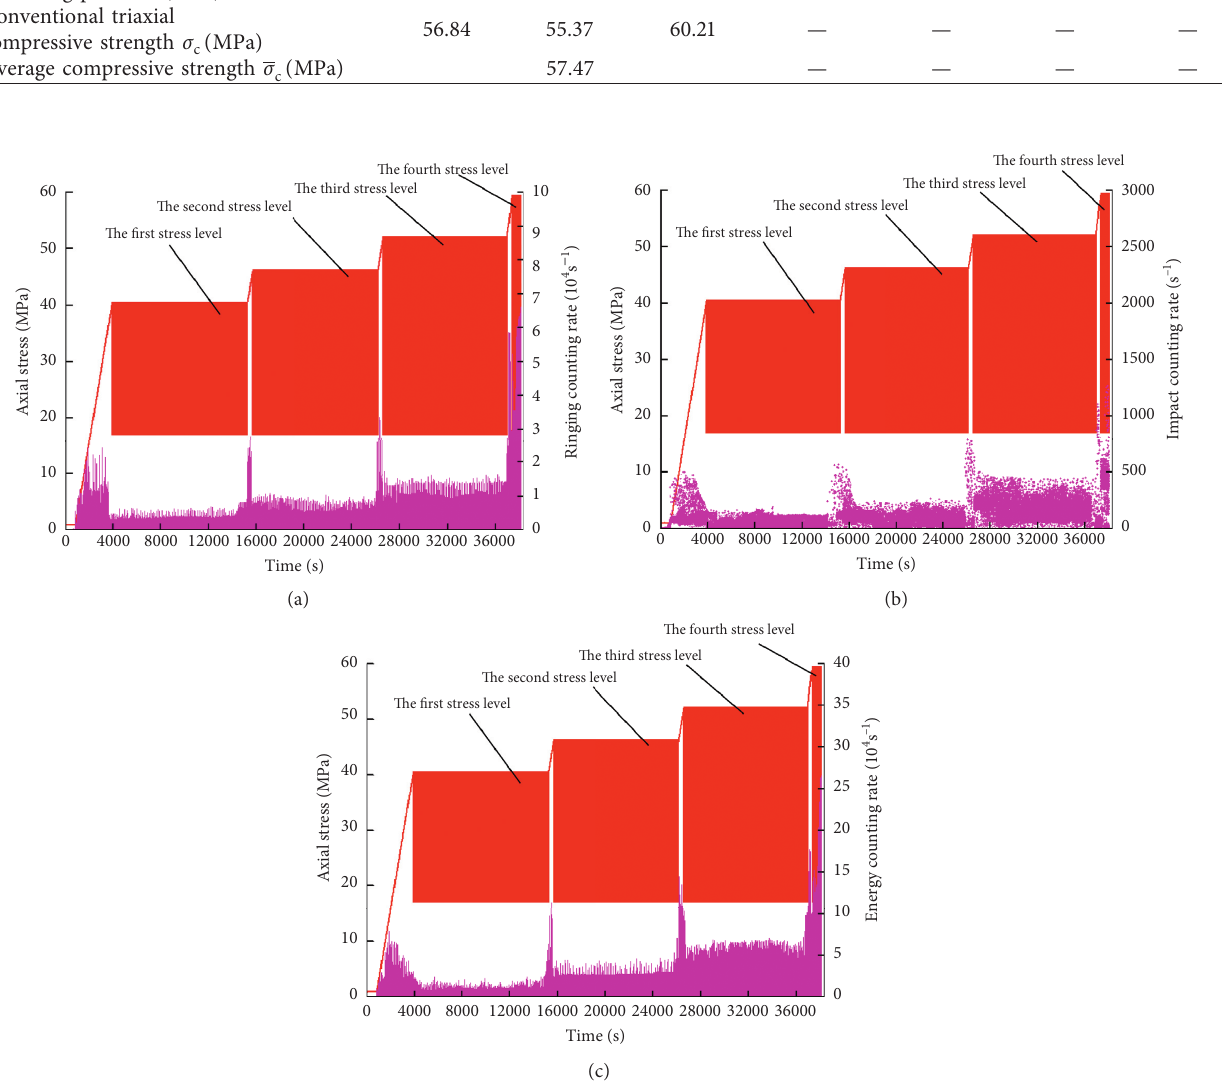
Figure 7: Acoustic emission characteristics of coal from triaxial tests under cyclic loading and different stress levels. (a) Ringing counting rate, (b) impact counting rate, and (c) energy counting rate.